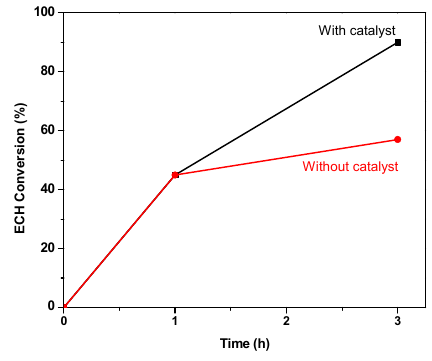
Figure 2. Hot filtration experiment.